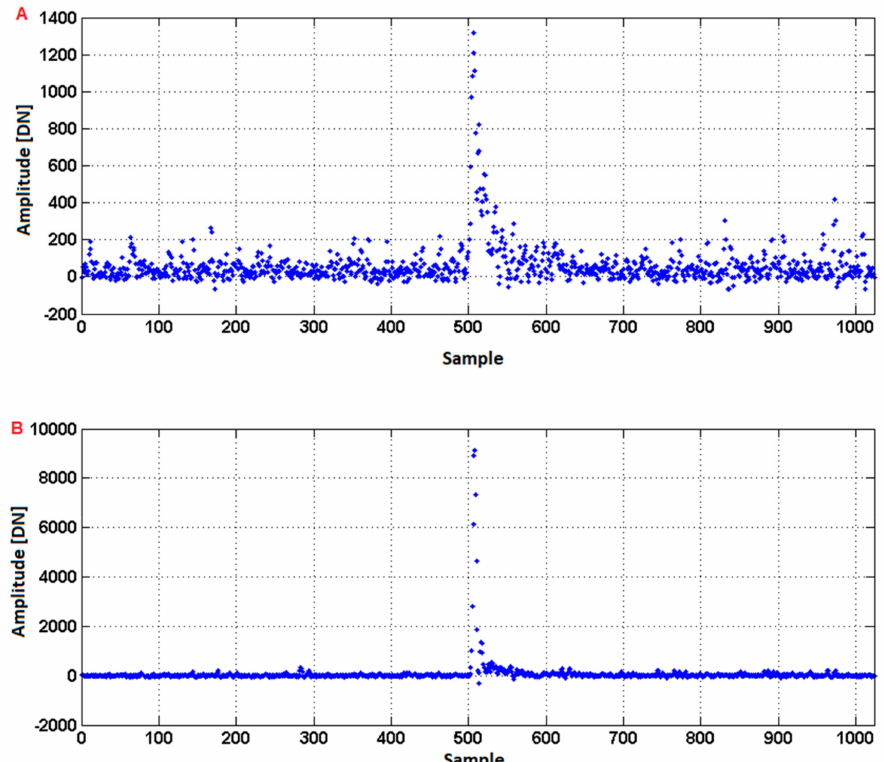
Figure 7. Example waves in which no subsequent echoes were found in the secondary